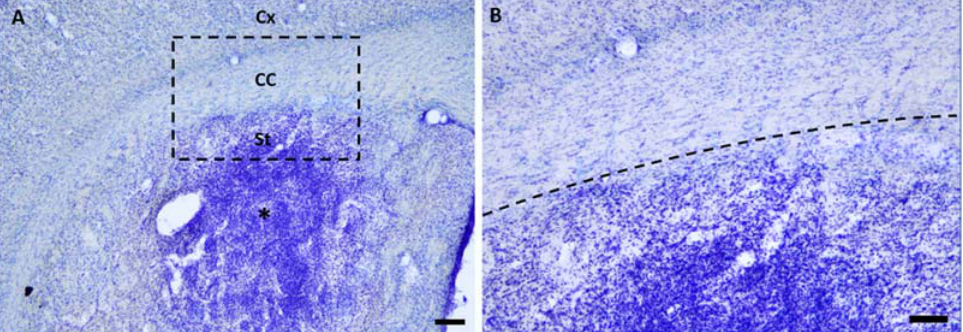
Figure 1. Primary focal striatal damage did not affect corpus callosum (CC) in early survival times: ( A ) Intense inflammatory response in the striatum (St, *) at 3 days following endothelin-1 (ET-1) microinjection. Primary damage is restricted to the dorsal striatum not comprising CC and cortex (Cx) ( B ) Higher magnification of image depicted in A. Scale bar: A 200 μ m; B 100 μ m.